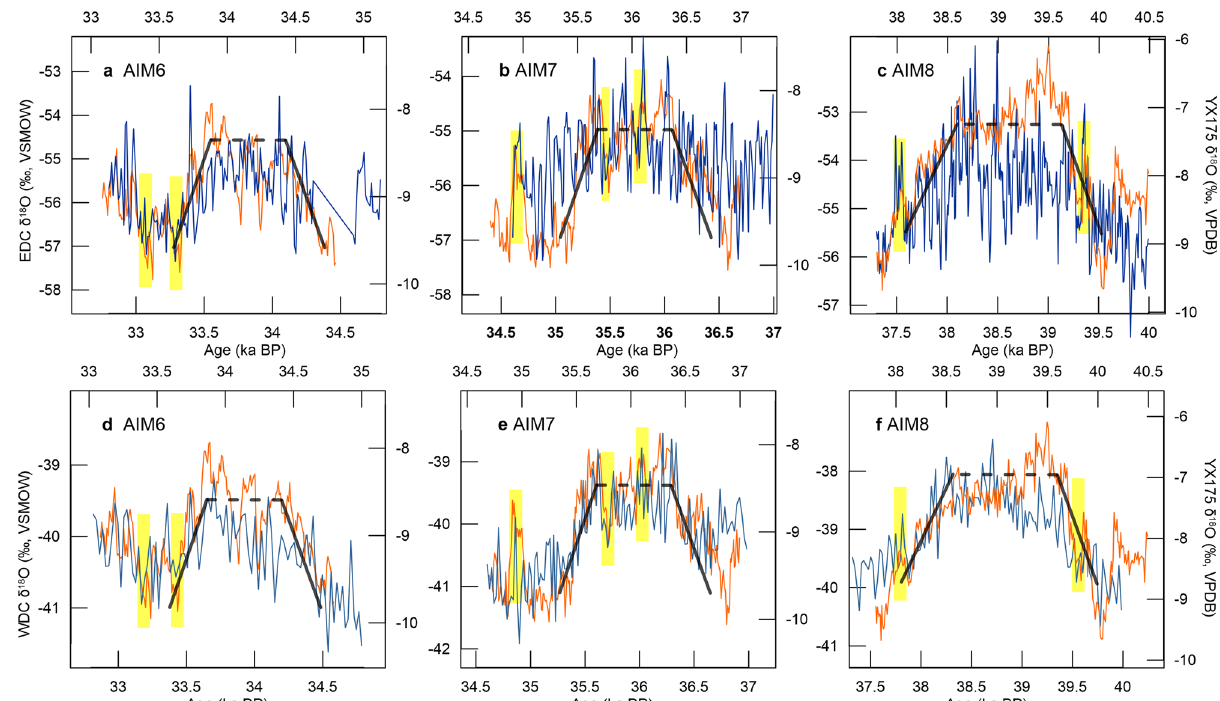
Fig. 3 The “ Trapezoid-style ” EASM changes during the AIM events. We aligned the weak monsoon events in YX (orange lines) and AIM events (including AIM6, AIM7 and AIM8 events) in the EDC δ 18 O ice ( a – c ) and WDC δ 18 O ice ( d – f ) records (blue lines). The comparison is within the AICC2012/ WD2014 chronology ’ s uncertainties, 500~900 years for AICC2012 and 350~400 years for WD2014 5,7,51,87 . Strong positive Pearson correlation coef fi cients are found of YX with EDC record ( r = 0.55, n = 750, p < 0.01, Fig. 1c, with the EDC record tuned older by 340 years), and with WDC record ( r = 0.74, n = 788, p < 0.01, Fig. 1c, with the WDC record tuned older by 200 years). Yellow bars indicate centennial to sub-centennial fl uctuations in three